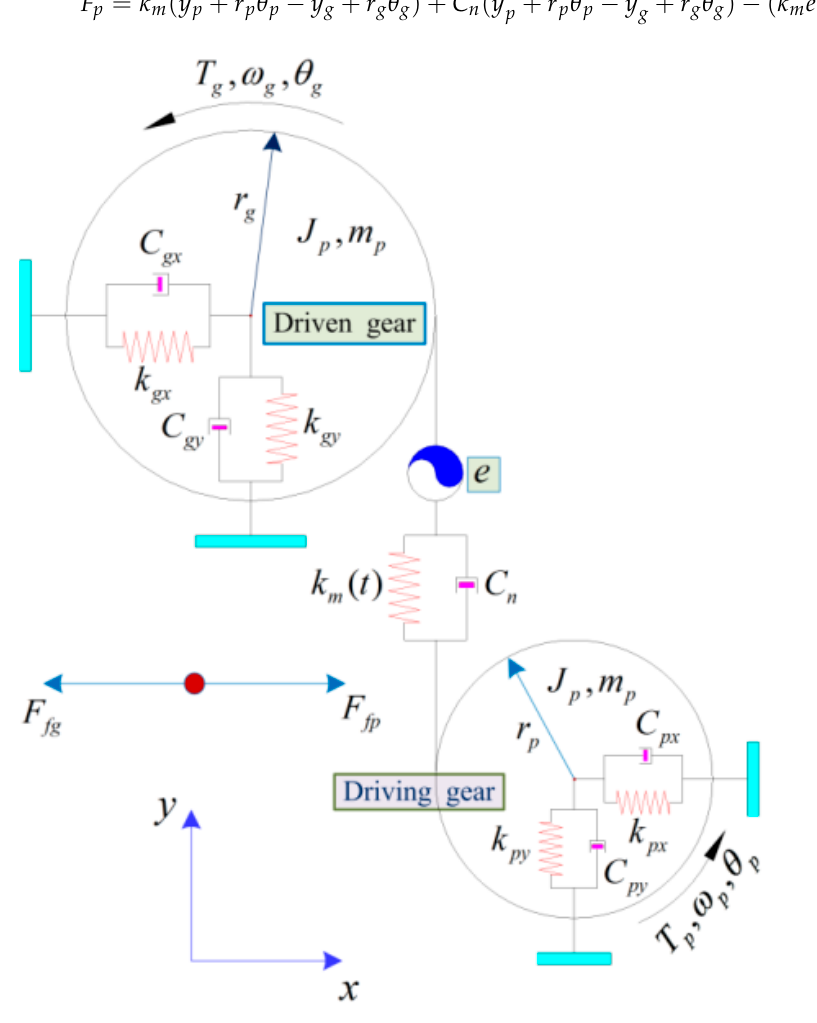
Figure 5. A general spur gear dynamic model considering MTS friction behavior. The tooth pair number in the meshing zone presents a periodic time-varying law during the meshing transient process of the spur MGP. Consider an MGP with a thermal steady state interfacial contact ratio between 1 and 2, the number of gear teeth in the alternate meshing. The entire meshing zone is set as a double teeth contact (DTC) zone